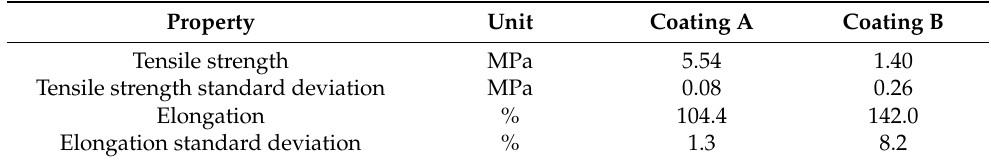
Table 4. Tensile data of conformal